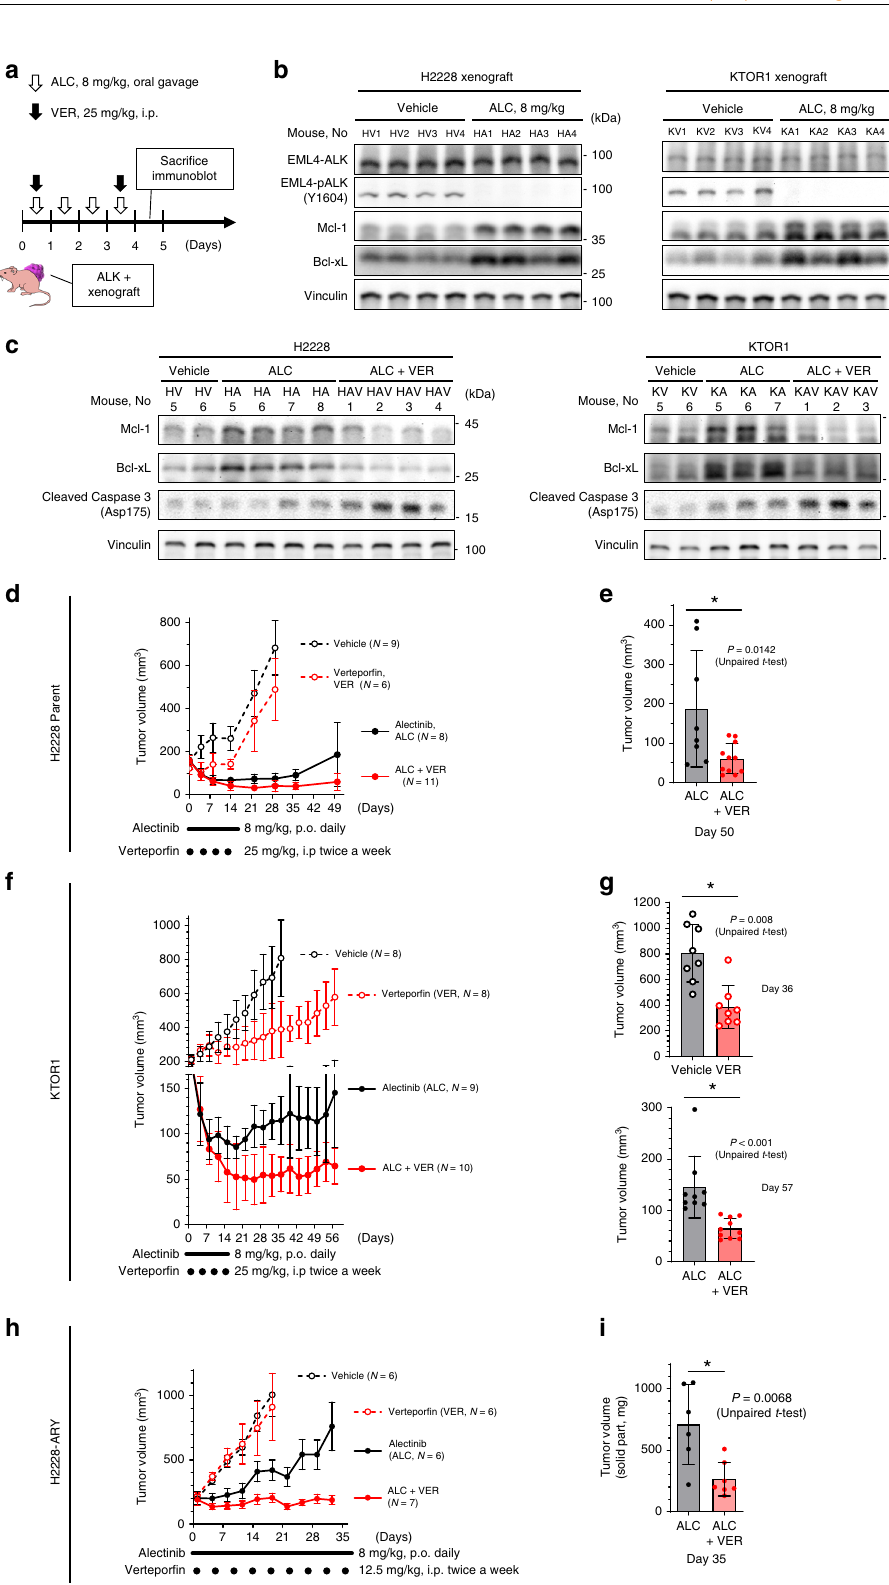
Apoptosis assay . Cells (2000 cells/well) were cultured in 386-well plates overnight and incubated with stepwise concentrations of the agents being tested for 24 h. Caspase 3/7 activity was assessed using the Caspase-Glo 3/7 Assay (Promega) according to the manufacturer ’ s manual. Three independent experiments were performed.